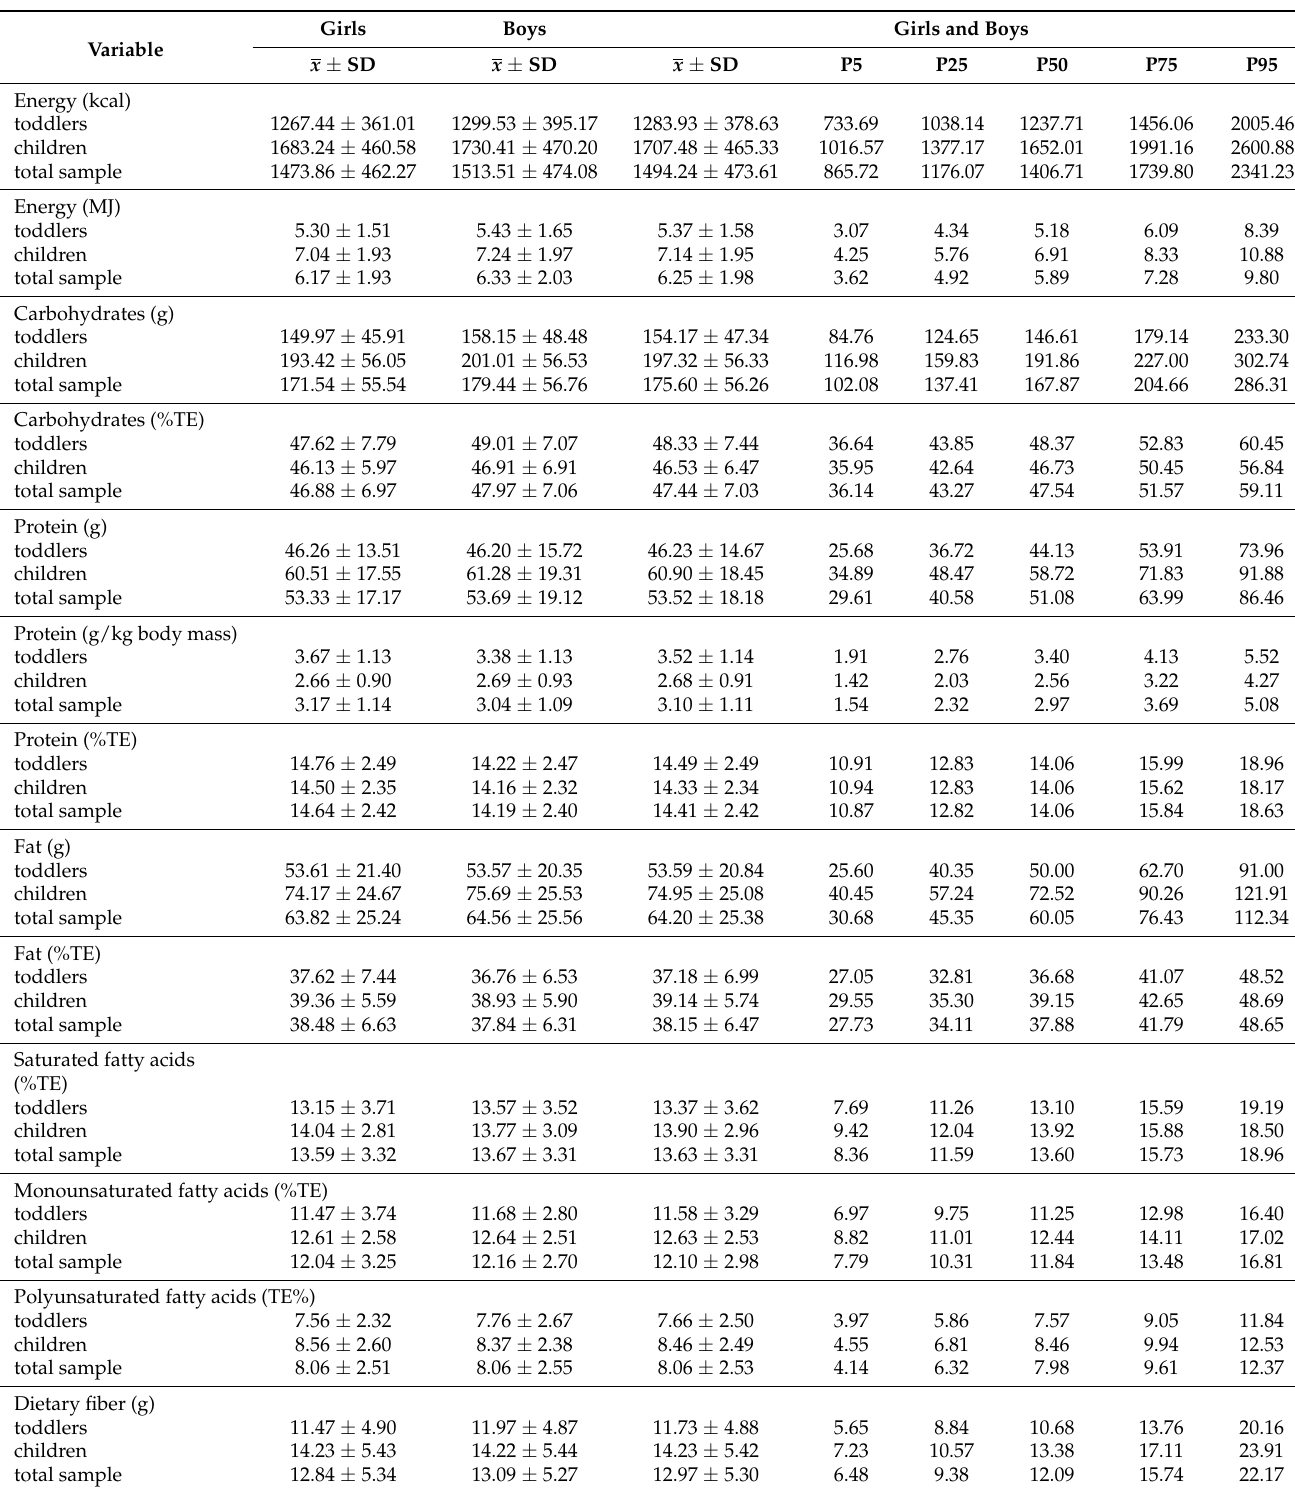
Table 4. Distribution of daily energy and macronutrients intake across age and gender categories in